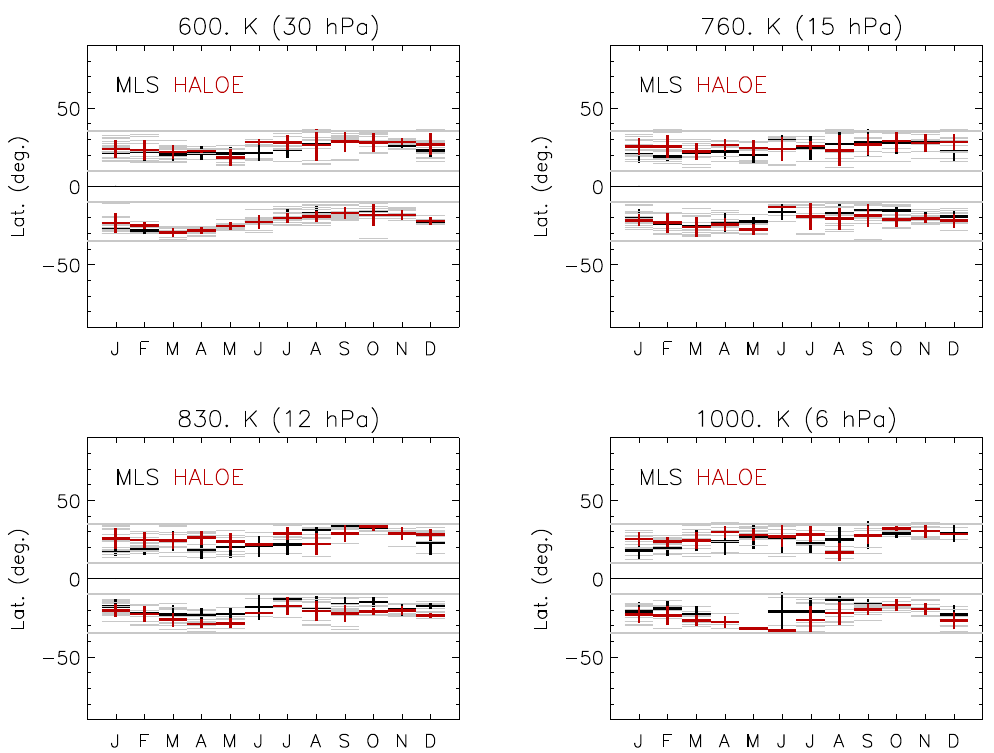
Fig. 7. Annual cycle of the subtropical barrier position (one value for each month) for the MLS (black) and HALOE (red) instruments at 600K, 760K, 830K, and 1000K. The figure shows the average over all years available for each sensor, also averaged over the various QBO phases. The horizontal grey lines define the latitude region between 10 and 35 degrees in both hemispheres.